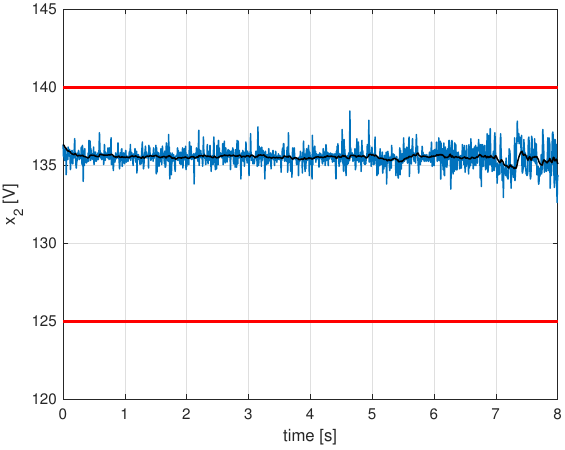
Figure 22. HV bus voltage (blue), filtered voltage (black) and voltage limits